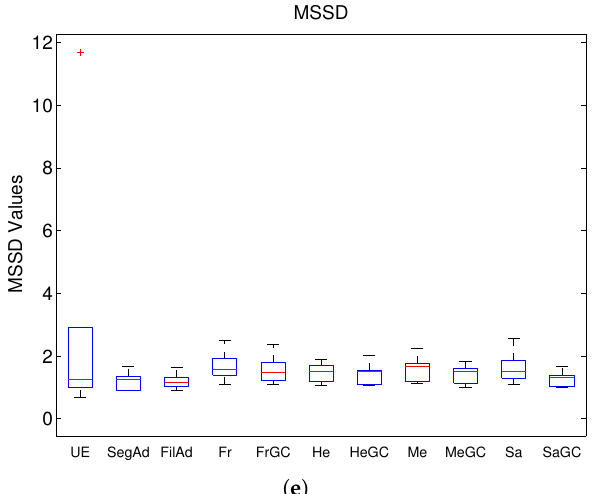
Figure 10. Comparison of all the methods. UE—Unenhanced, SegAd—SegAdded, FilAd—FilterAdded, Fr—Frangi, FrGC— FrangiGC, He—Hessian, HeGC—HessianGC, Me—Meijering, MeGC—MeijeringGC, Sa—Sato, SaGC—SatoGC. ( a ) DICE; ( b ) ASSD; ( c ) RAVD; ( d ) VOE; ( e ) MSSD.